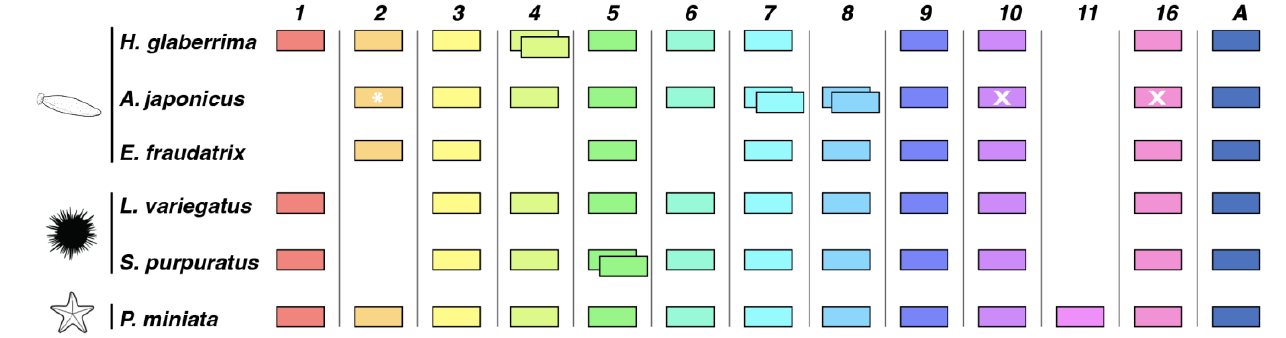
Figure 9. Summary of Wnt gene compositions of the echinoderm species assessed in this study. This schematic is based on a phylogenetic analysis of Figure 2. Asterisks depict manually characterized genes. White X depicts genes that could not be found in the NCBI database.